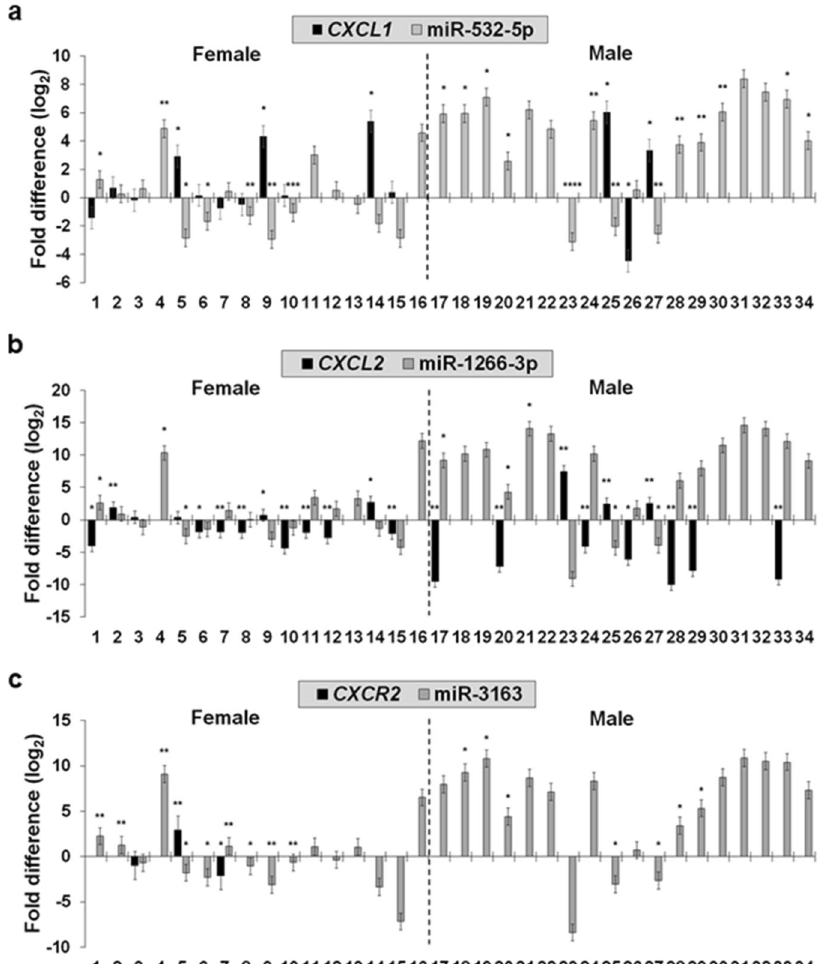
Fig. 5 Quantitative analysis of CXCL mRNAs and microRNA copy numbers from Stage I LUAD patients. a – c Absolute quanti fi cation of CXCL1 and miR-532-5p in ( a ), CXCL2 and miR-1266-3p in ( b ), and CXCR2 and miR-3163 in ( c ). Black and gray bars present quantitative fold differences of chemokine genes ( n = 3) and corresponding miRNAs ( n = 3), respectively, in primary lung tumors compared with normal lung tissues resected from female ( n = 16) and male ( n = 18) Stage I LUAD patients. x and y axes indicate patient IDs (female patients, 1 – 16 and male patients, 17 – 34) and quantitative fold differences at log 2 , respectively. Statistical differences indicated as * P < 0.05, ** P < 0.01, *** P < 0.001, and **** P < 0.0001 from two-sample t